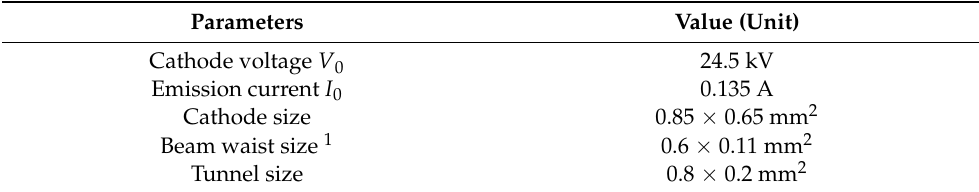
Table 1. Design parameters of the sheet-beam electron gun.